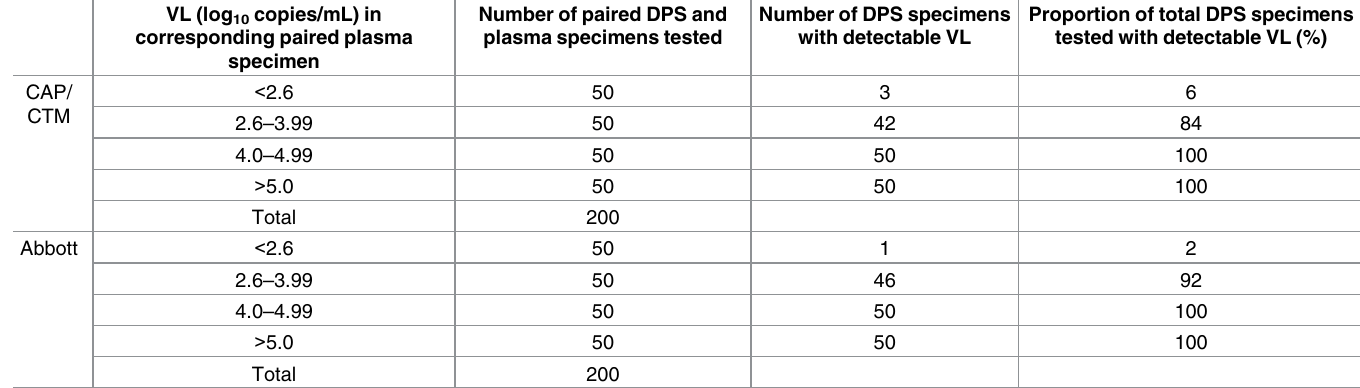
Table 2. HIV-1 RNA detection rates of dried plasma spot (DPS) specimens paired with plasma specimens prepared from patient support centersin Nyanza, Kenya. (November2012 to February 2013). VL (log 10 copies/mL) in corresponding paired plasma